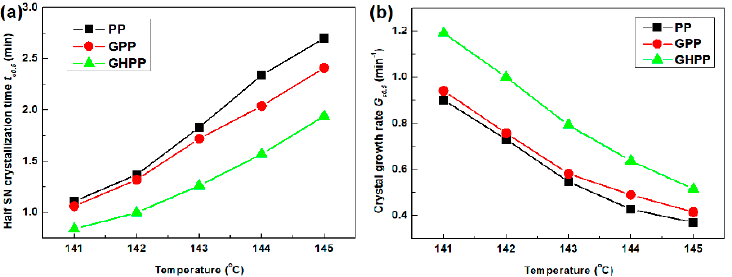
Figure 8. ( a ) Half crystallization time for crystal growth, t c0.5 , and ( b ) Crystal growth rate parameter, G c0.5 , as a function of crystallization temperature T cSN for PP, GPP and GHPP.